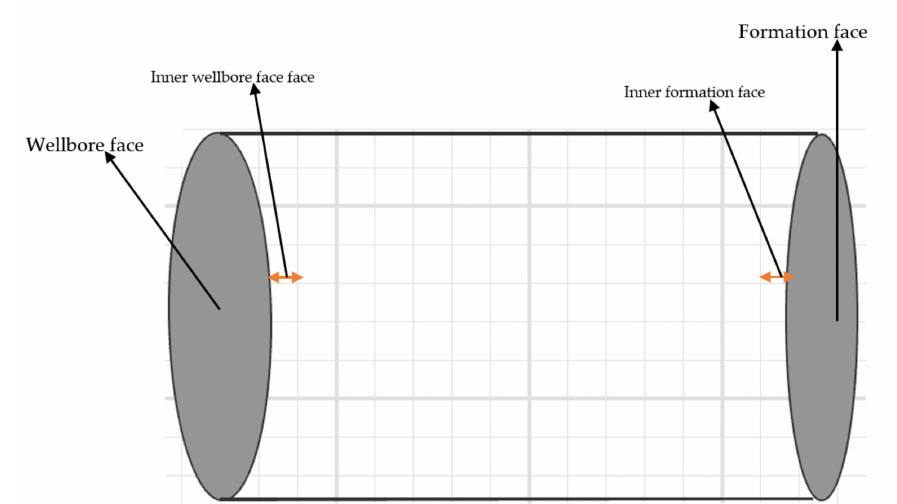
Figure 20. Areas of a sandstone core sample showing the wellbore face, inner wellbore face, formation face, and inner formation